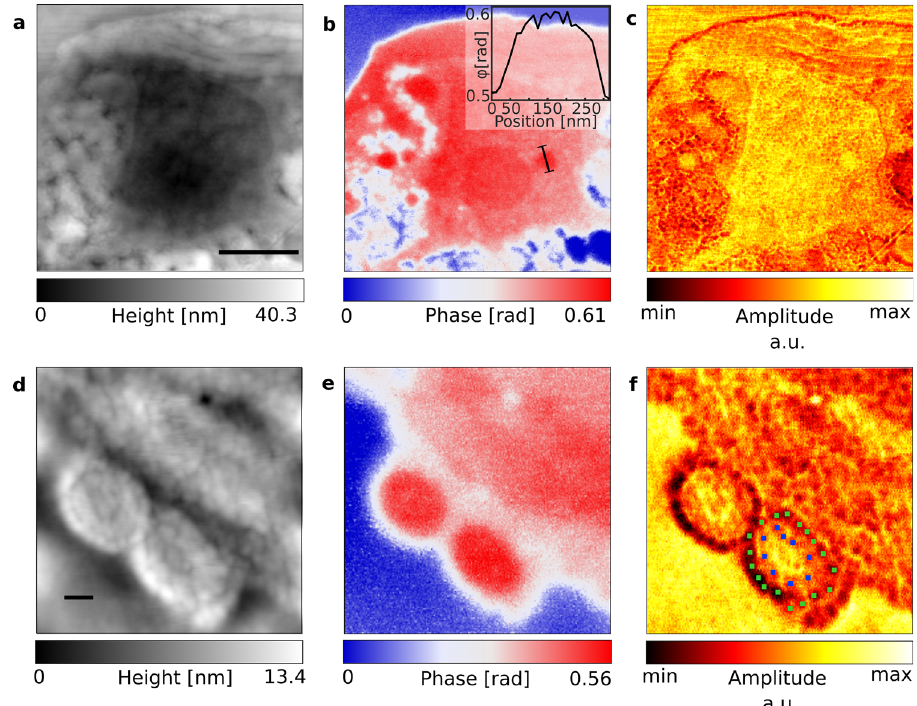
Fig. 4 Imaging of speci fi c intracellular structures of a C. reinhardtii cell. The nuclear region is visualized by AFM topography ( a ) with the scale bar showing 1 µ m, sSNOM phase imaging at 1655 cm -1 ( b ) with the inset showing a line pro fi le across a nuclear body, and sSNOM amplitude ( c ). The axoneme of the fl agellum is similarly visualized using AFM topography ( d ) with the scale bar showing 100 nm, sSNOM phase imaging at 1656 cm -1 ( e ) and sSNOM amplitude ( f ), with the doublet microtubules (green marks) and the radial spokes (blue marks) of the fl